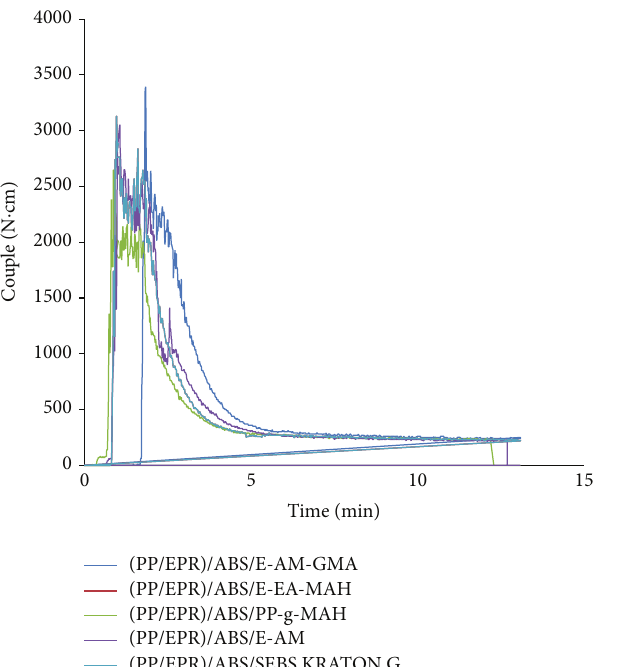
Figure 3: Variation of the torque exerted by the screws “rollers” internal mixer HAAKE PolyLab System on mixtures (PP/EPR)/ ABS/compatibilizers at a rate of 1.5% of the five compatibilizers.